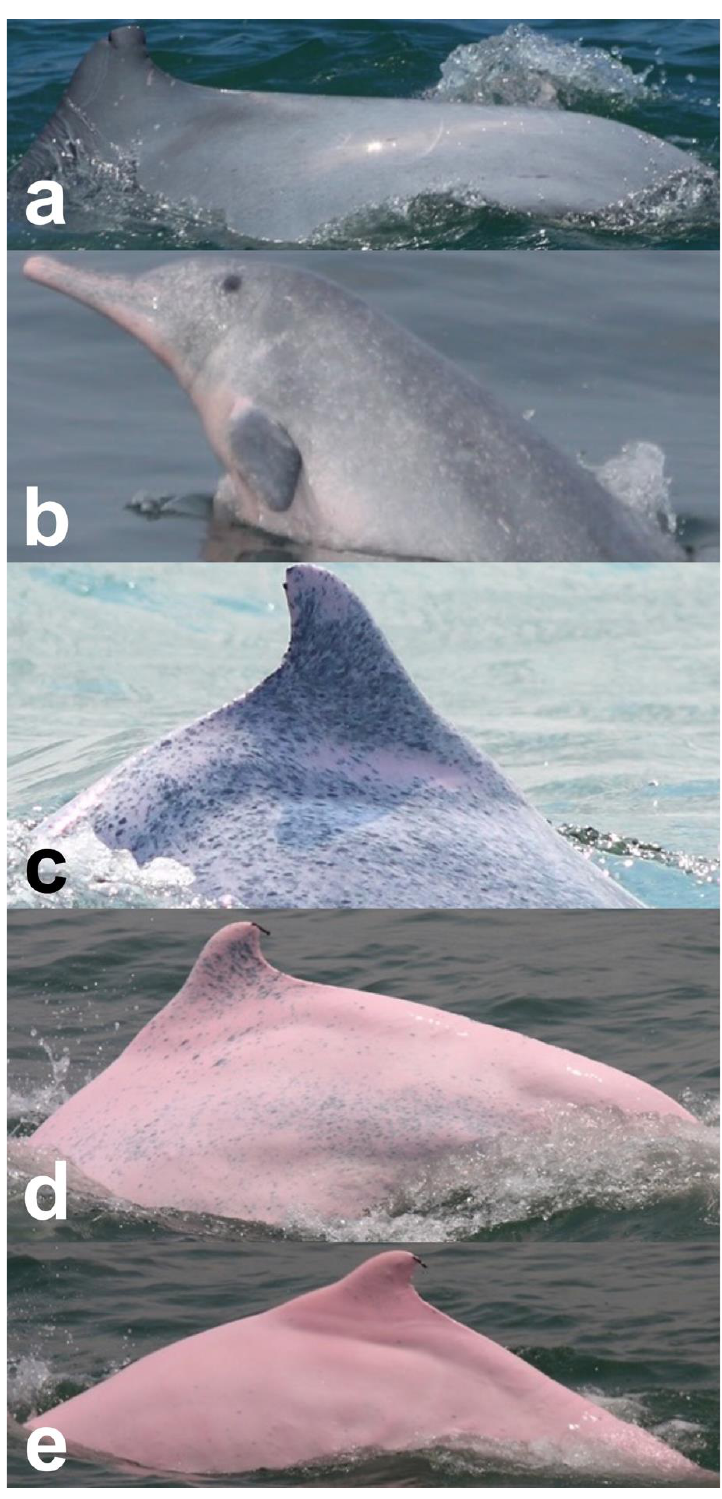
Figure 2. Images of Sousa chinensis in different coloration stages: ( a ) calf, ( b ) mottled stage, ( c ) speckled stage, ( d ) spotted adult, and ( e ) unspotted adult.